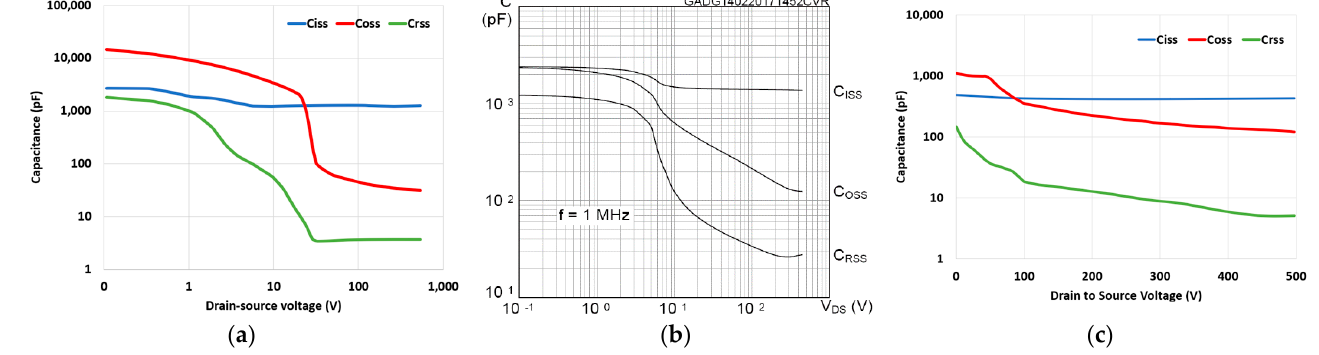
Figure 8. The Capacitance variations: ( a ) Si MOSFET (Toshiba TK14G65W) [55]; ( b ) SiC MOSFET (STMicroelectronics SCTL35N65G2V) [36]; ( c ) GaN HEMT (GaNPower GPI65060DFN) [56].